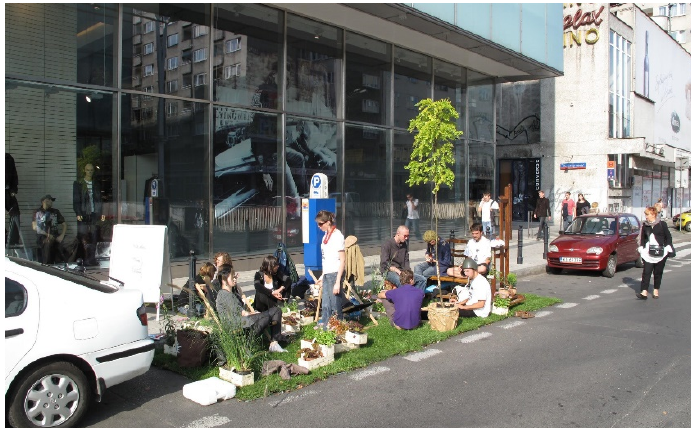
Figure 3. First Park(ing) Day in Warsaw (2009) organised by K. Herman. (photo K.